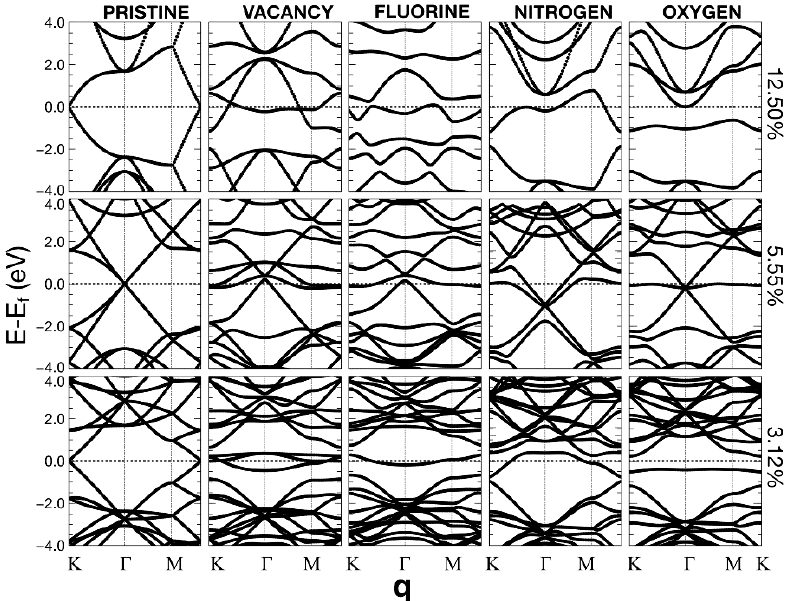
Figure 10. Energy band structures. The left column corresponds to pristine graphene for unit cells of different sizes (containing 2N × N carbon atoms). The 12.5% of dopant (or vacancy) corresponds to a unit cell of 8 bits (N = 2). 5.55% compares to a unit cell with N = 3; 3.12% refers to a unit cell with N = 4. The Fermi energy corresponds to the dotted lines. The second column from the left relates to different vacancy percentages. The middle column shows fluorine’s influence as a dopant on the energy band structure when its presence changes several ratios. The other two columns refer to nitrogen and oxygen, respectively.